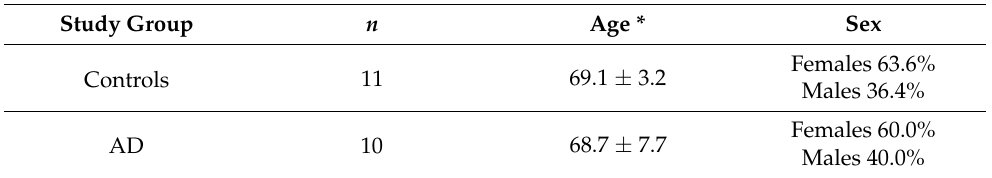
Table A2. Demographic information of the biopsy donors of olfactory mucosa (OM) cell lines used for inductively coupled plasma mass spectrometry